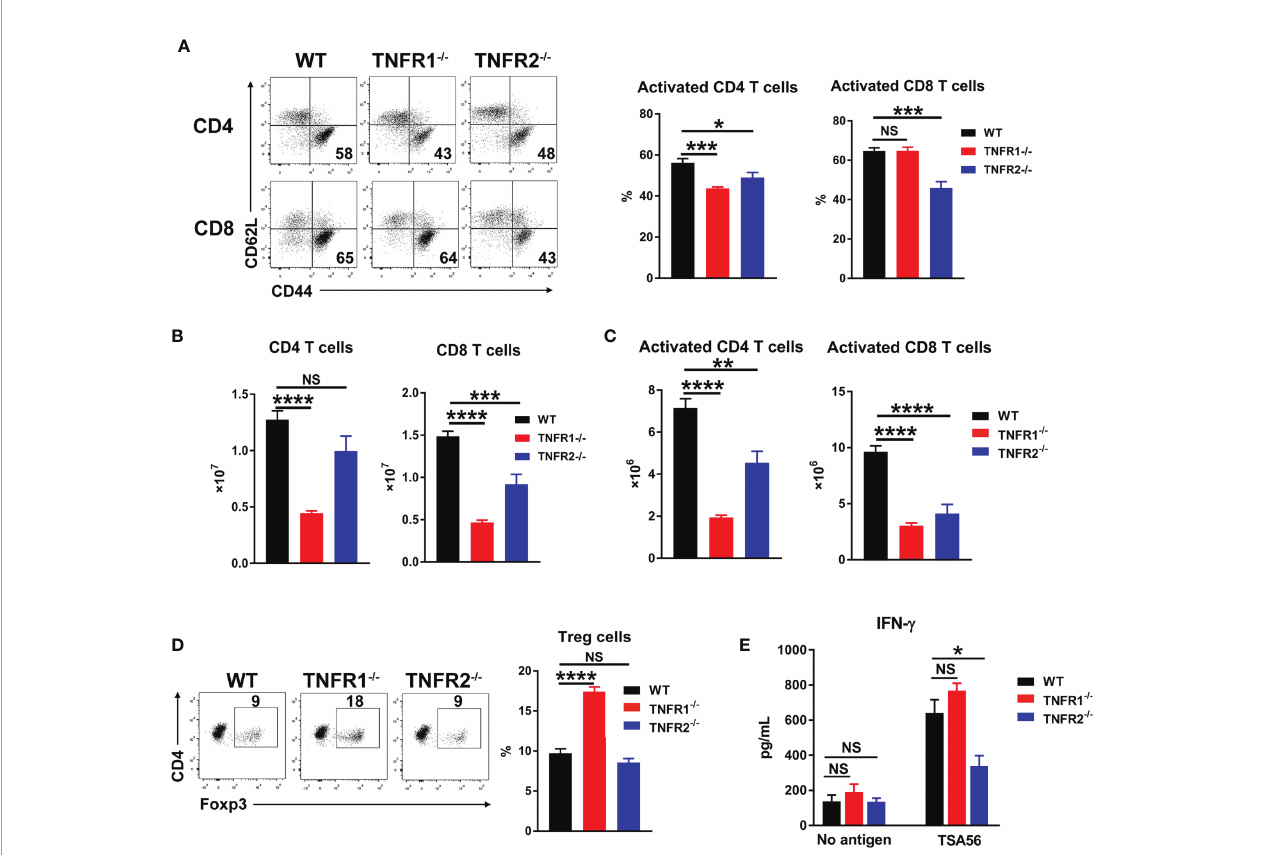
FIGURE 8 | Lack of either TNFR1 or TNFR2 resulted in decreased anti-bacterial T cell responses. Mice (5/group) were infected, as in Figure 7 . Lymphocytes were isolated from spleen and lungs at D8 and analyzed by fl ow cytometry. (A) The percentages of activated T cell subsets in the spleens. (B) The absolute numbers of T cell subsets in the spleens were counted and calculated according to fl ow cytometric analysis. (D) The percentages of regulatory T (Treg) cells. (E) Spleen cells (5 ×10 5 ) were cultured in 96-well plate with or without 5 µg/mL of TSA56. Supernatants were collected at day 3, and IFN- g production was measured by ELISA. Data are shown as mean ± SD from single experiments and are representative of at least two experiments performed. A one-way ANOVA with a Tukey ’ s multiple comparisons test was used for statistical analysis. * p <0.05; ** p <0.01; *** p <0.001, **** p <0.0001; NS, not signi fi